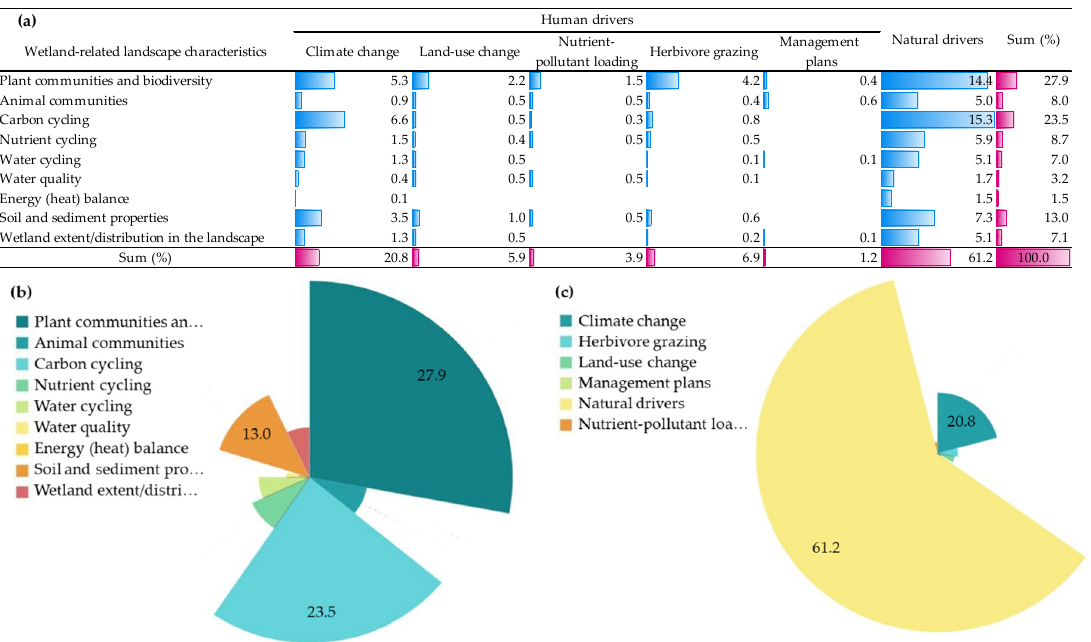
Figure 2. ( a ) Result matrix (heat map) showing the share of published studies addressing each combination of change driver (columns) and landscape characteristic (rows); ( b ) total share of studies addressing each characteristic; ( c ) total share of studies addressing each change driver. All values are in percent (%) of total 893 studies. Blue bars in non-sum cells illustrate the share (%) of studies of each driver-characteristic combination. Red bars in the sum column/row illustrate the total share (%) of studies of each characteristic (sum column) or each driver (sum row). In gray-shaded cells, the share value is zero. (For interpretation of the colors in this table, the reader is referred to the web version of the article.)